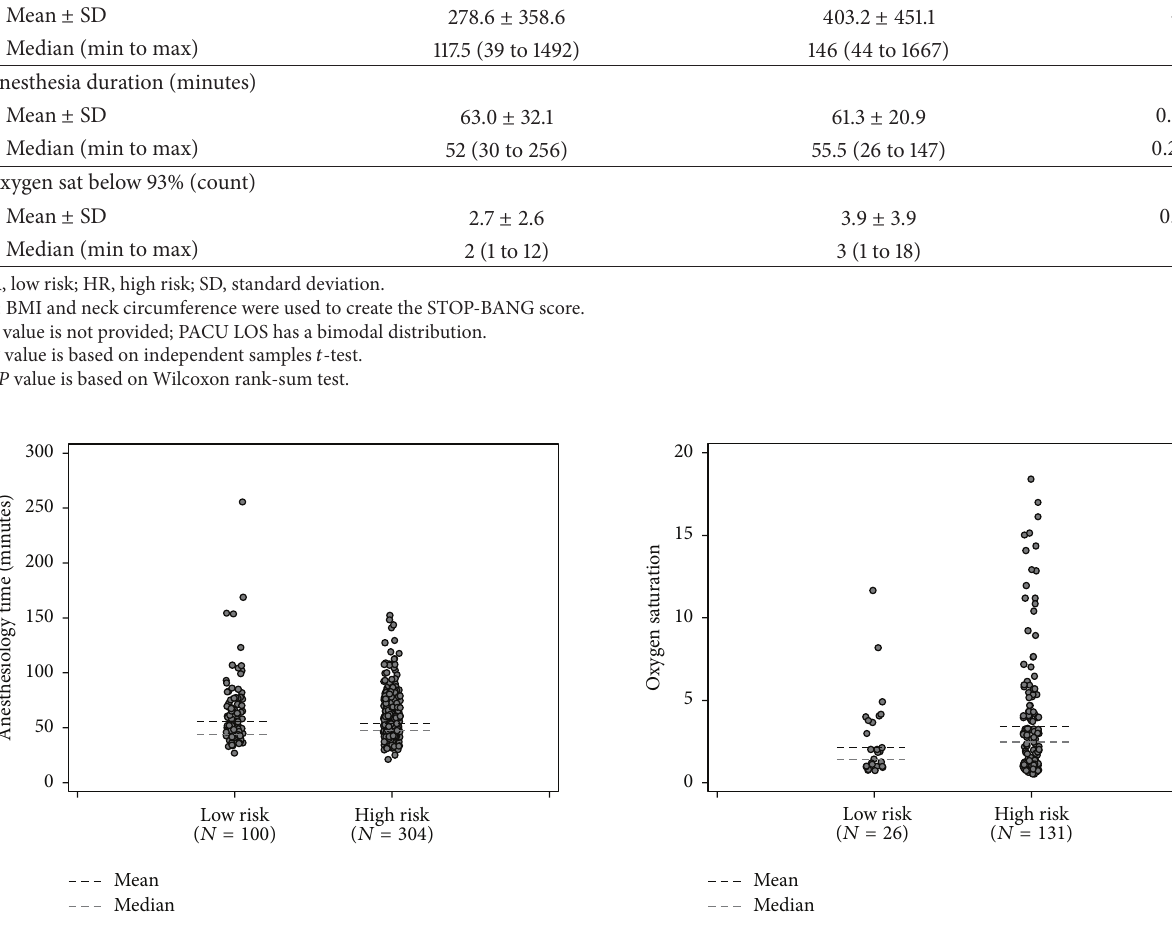
Figure 3: Oxygen saturation by low and high risk patients based on STOP-BANG